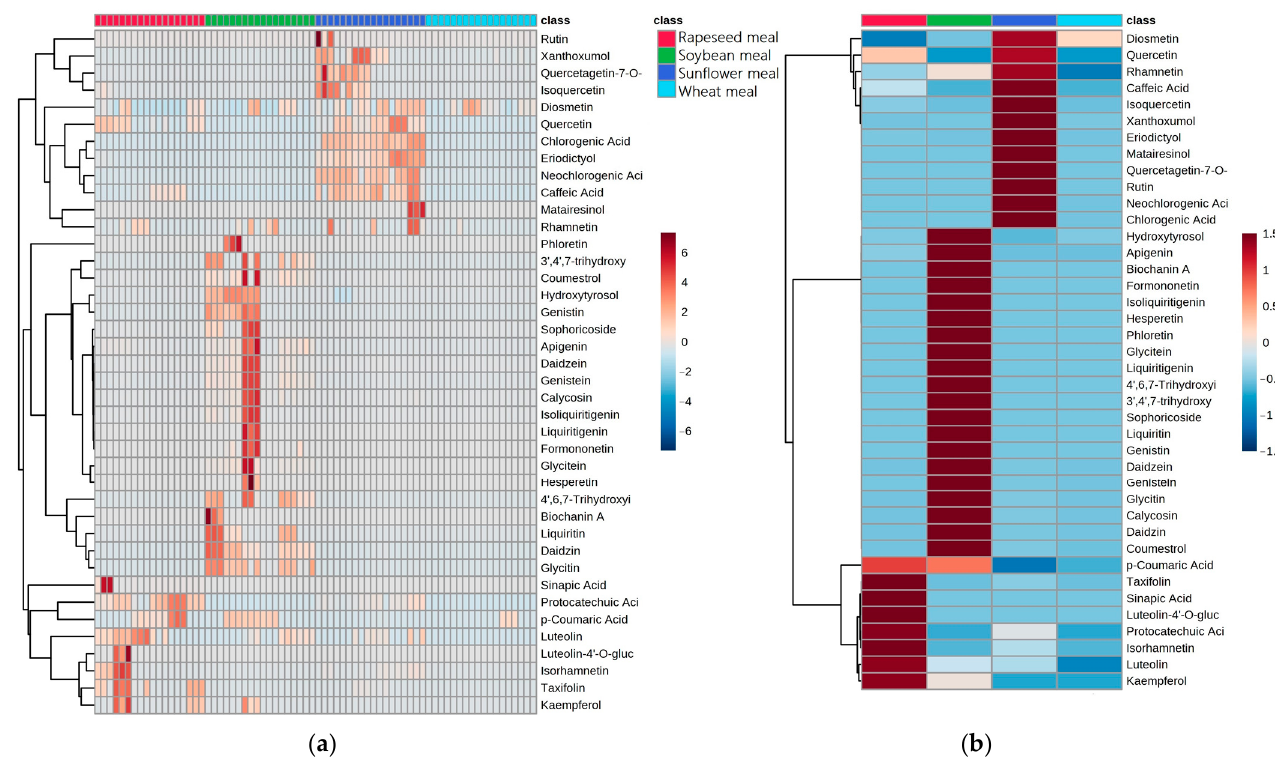
Figure 2. Heatmap of 40 significant phytoestrogens detected in soya, sunflower, rapeseed and wheat meal samples. Original data shown in a heat map ( a ) and gathered with the group averages ( b ), with automatically generated scaled intensity bars.